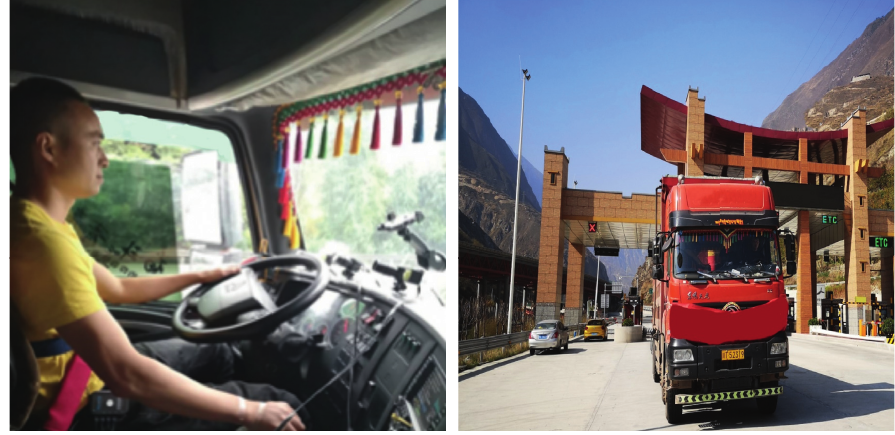
Figure 2: Experimental drivers and